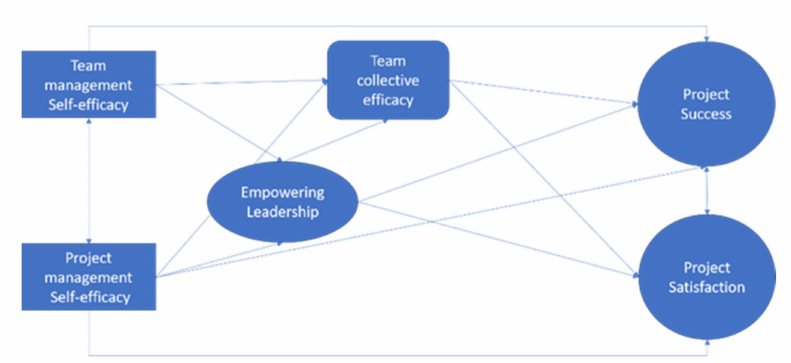
Figure 1. Future research paths pattern map: testable hypothesized